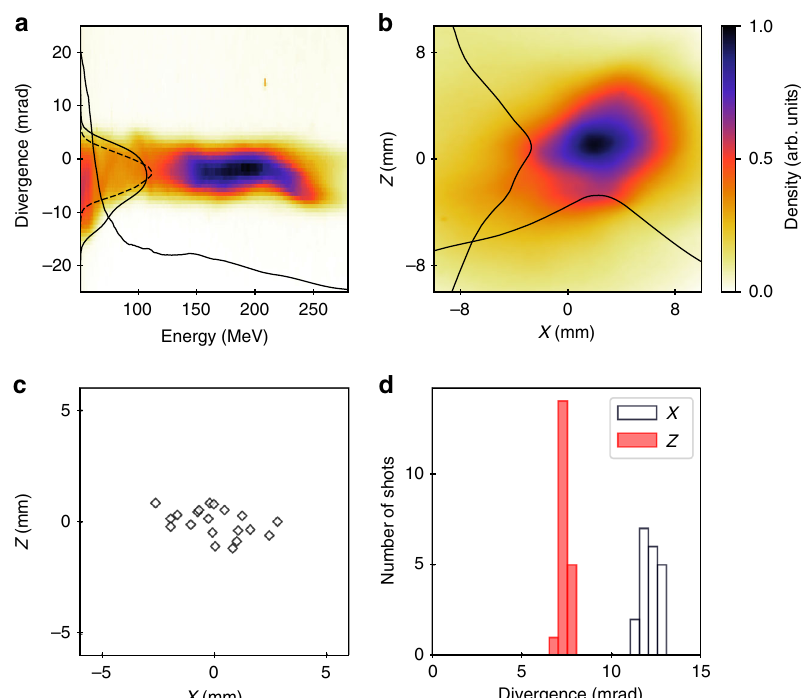
Fig. 2 Measured LWFA beam energy and transverse distribution without QUAPEVA. a Measurement with the spectrometer before the fi rst screen, with corresponding energy pro fi le and vertical divergence evaluated by superimposing the divergence in energy slices of ±1 MeV and renormalised to the charge in the given slice (solid line), and in the case of 176 ± 5 MeV (dashed line). b Electron beam transverse distribution observed on the fi rst LANEX screen located at 64 cm from the source, without spectrometer, with corresponding horizontal and vertical pro fi les. c Shot-to-shot measured pointing stability and